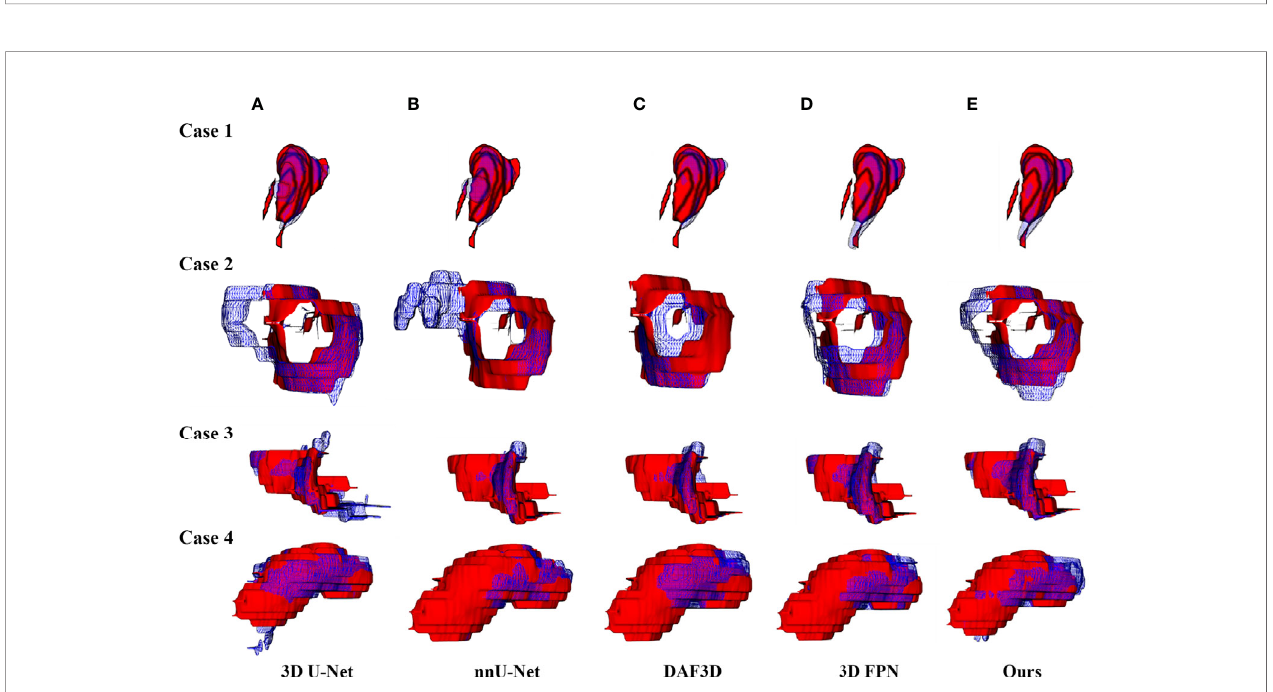
FIGURE 5 | 3D visualization of the automatic segmentation performance. Rows denote segmentation outcomes on four different CT volumes respectively. Columns demonstrate the visualized comparisons between the segmented surface (blue gridlines) and ground truth (red volumes) under fi ve different automatic segmentation methods: (A) 3D U-Net (10), (B) nnU-Net (32), (C) DAF3D (14), (D) 3D FPN (12), and (E) our method,